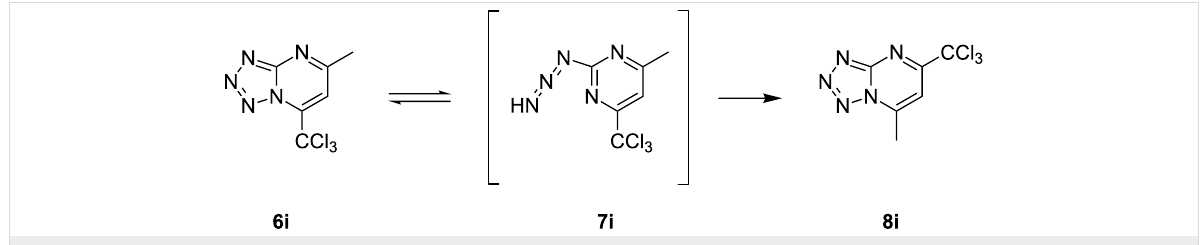
Figure 7: Representation of the possible equilibrium existing between 6i , 7i , and 8i .